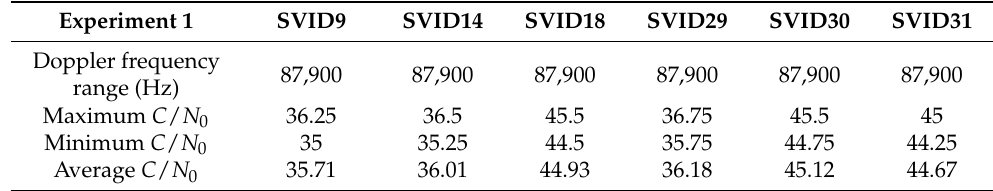
Table 1. Statistical table of experiment 1 Results.